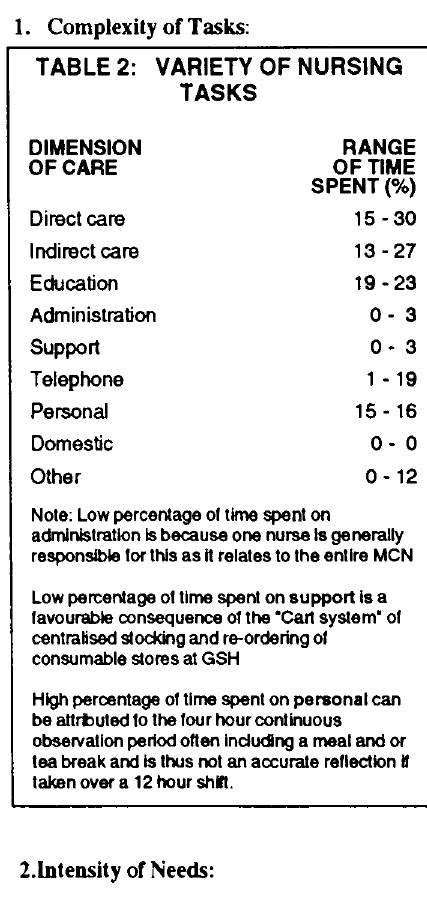
TABLE 2: VARIETY OF NURSING